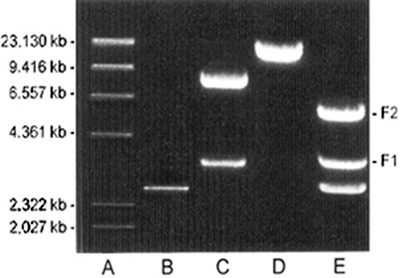
Restriction digest of the 7-kb chromosomal insert from the STM1-A plasmid
with EcoRI (C), HindIII
(D), and EcoRI and
HindIII (E) restriction endonucleases.
HindIII digested λ DNA (A); pUC19 alone
(B).